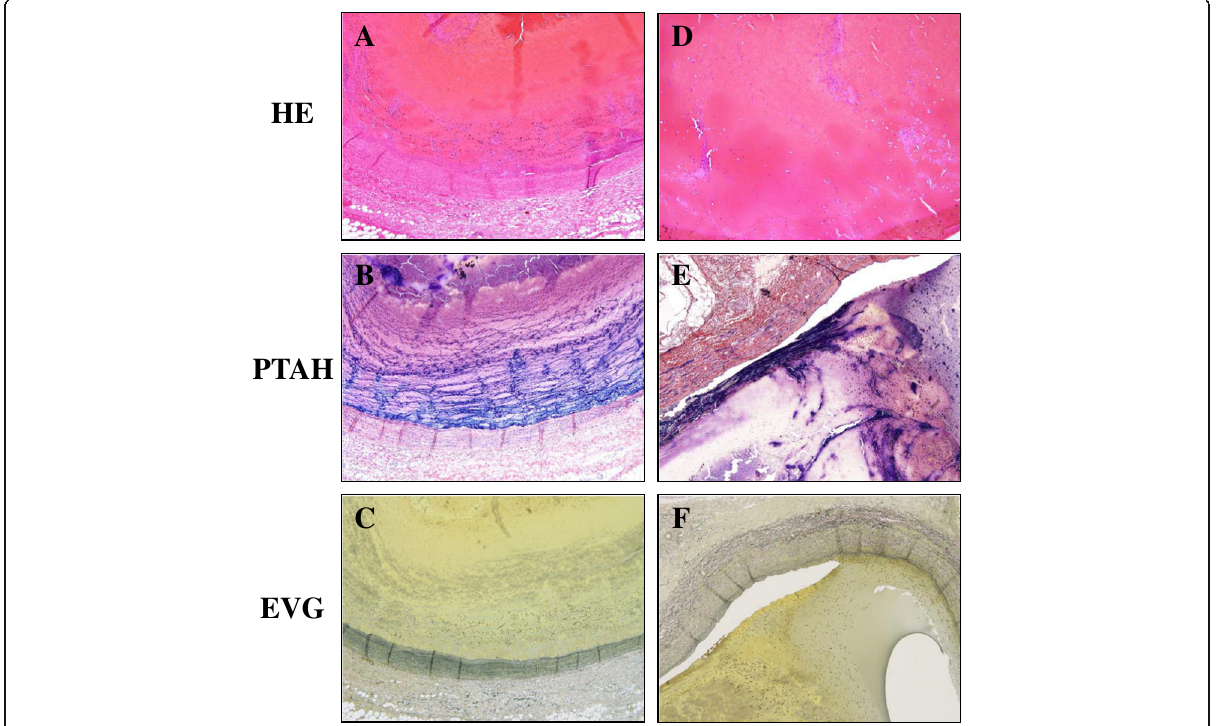
Fig. 2 Histological images of the thrombi in the lung and deep veins. No signs of organization or vascular fibrosis were observed. a – c Lung. d – f Deep vein. Hematoxylin and eosin staining ( a , d ), PTAH (phosphotungstic acid hematoxylin) staining ( b , e ), and EVG (Elastica van Gieson) staining ( c , f